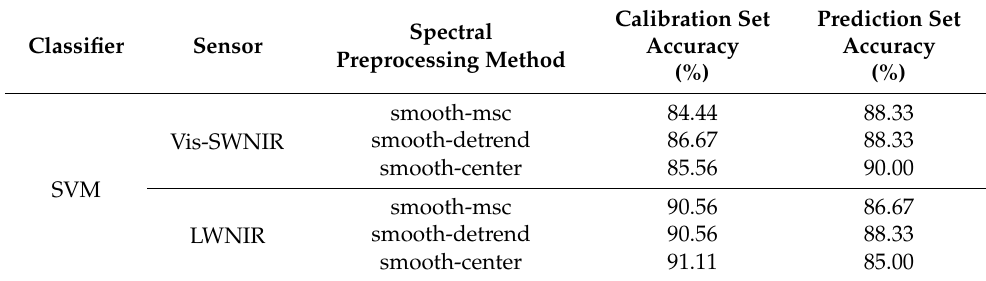
Figure 6. The preprocessed spectra by smooth-msc ( a , d ), smooth-detrend ( b , e ), and smooth-center ( c , f ) methods for the Vis-SWNIR and LWNIR regions, respectively. Table 3. The classification performance of the SVM models established by different preprocessing methods.